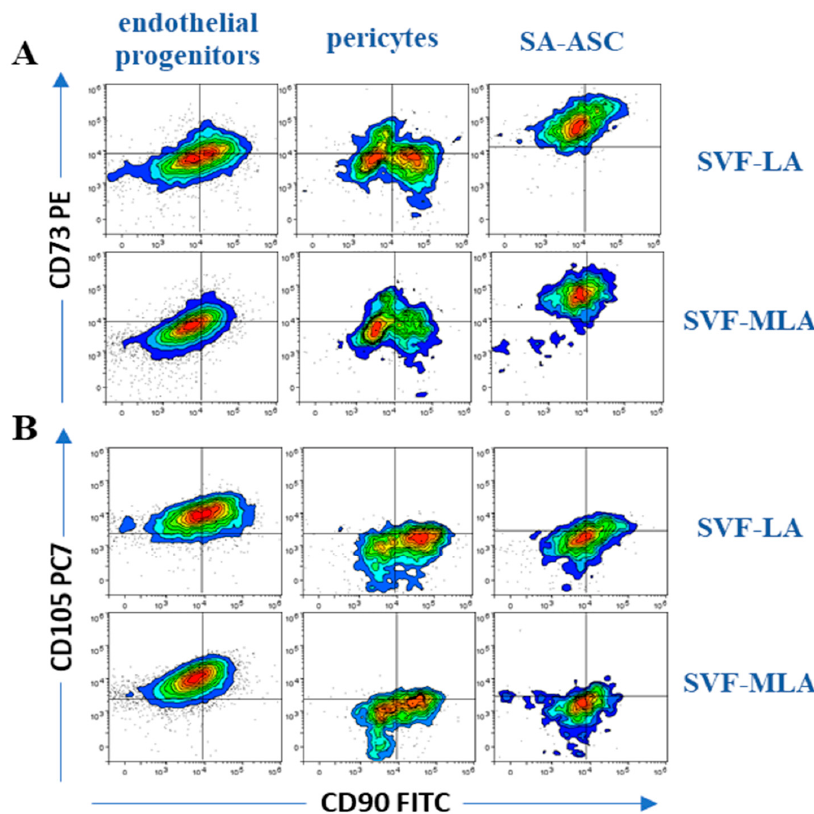
Figure 3. Expression of mesenchymal stem cell markers in SVF cells obtained from SVF-LA or its SVF-MLA counterpart. The co-expression of the mesenchymal-associated markers CD90 vs CD73 ( A ) and CD90 vs CD105 ( B ) are shown for the three progenitor populations: endothelial progenitors, pericytes and SA-ASC. One representative experiment is shown. Summarized results of the determined immunophenotypes for the three progenitor populations and leukocytes are shown in Table 1, n = 12.